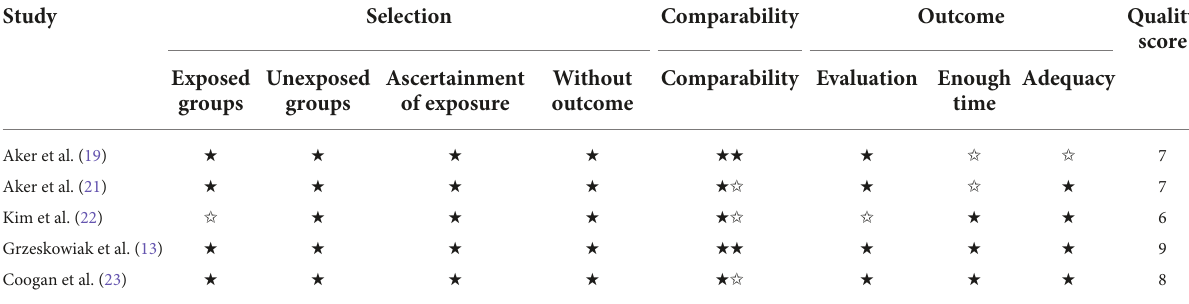
TABLE 2 Results of quality evaluation using the NOS for included cohort studies.